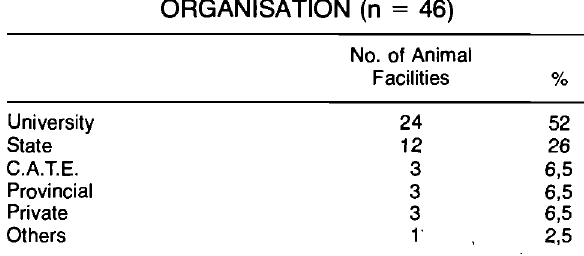
Table 1: NUMBER AND PERCENTAGE OF SURVEY RESPONDENTS IN RELATION TO THE TYPE